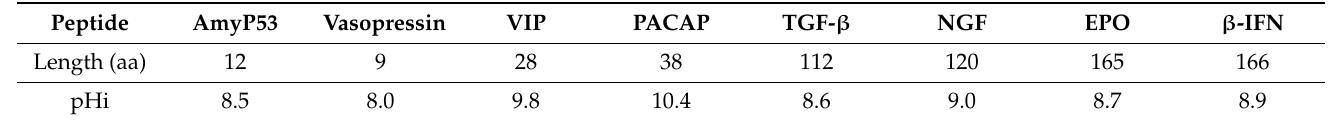
Table 4. Therapeutic peptides delivered to the brain via the intranasal route.